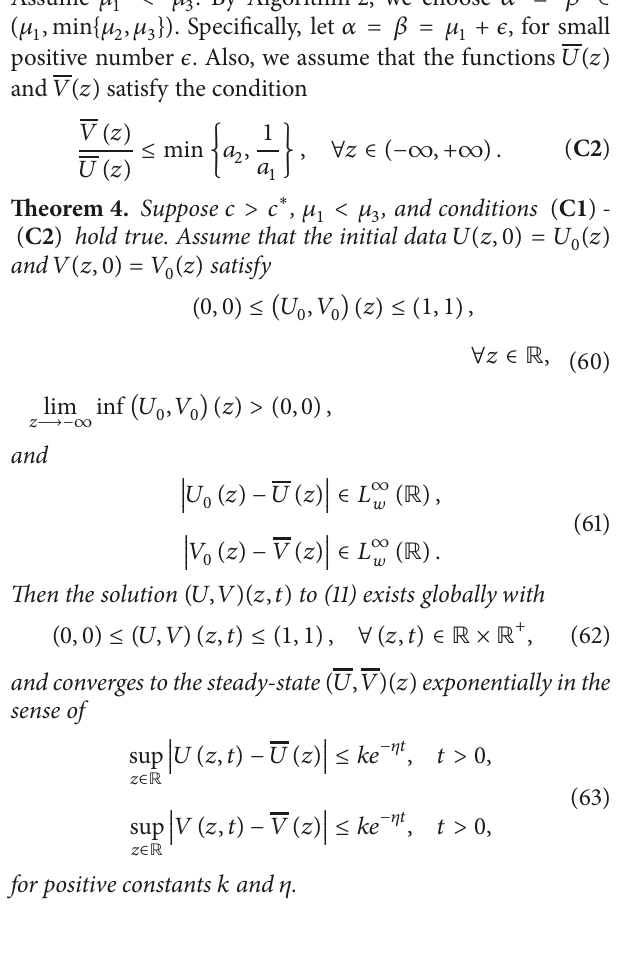
Algorithm 2. Two mechanisms are valid to choose 𝛼 and 𝛽 so that all conditions in (49) and (55)